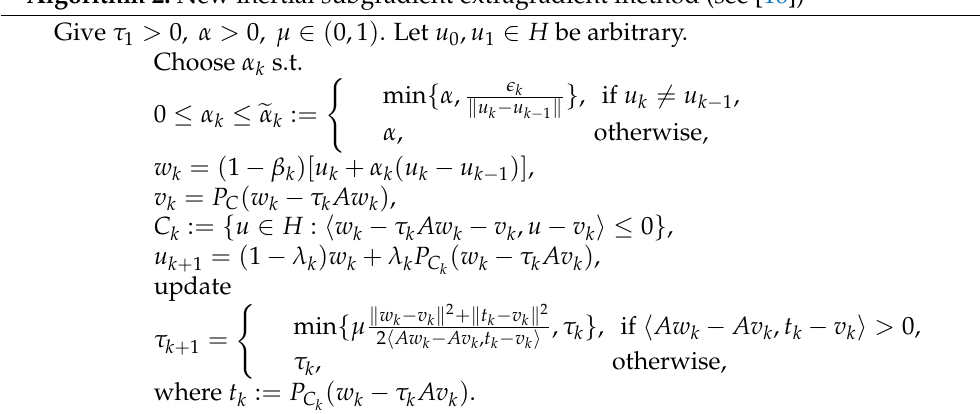
Algorithm 2: New inertial subgradient extragradient method (see